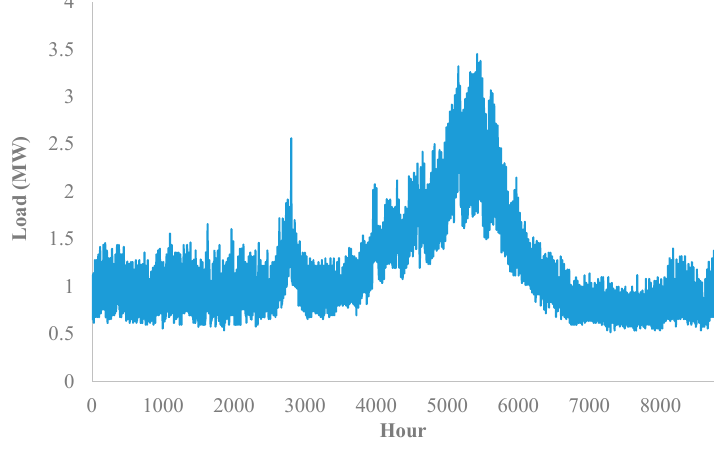
Figure 3. Load of Kythnos Island in 2019.